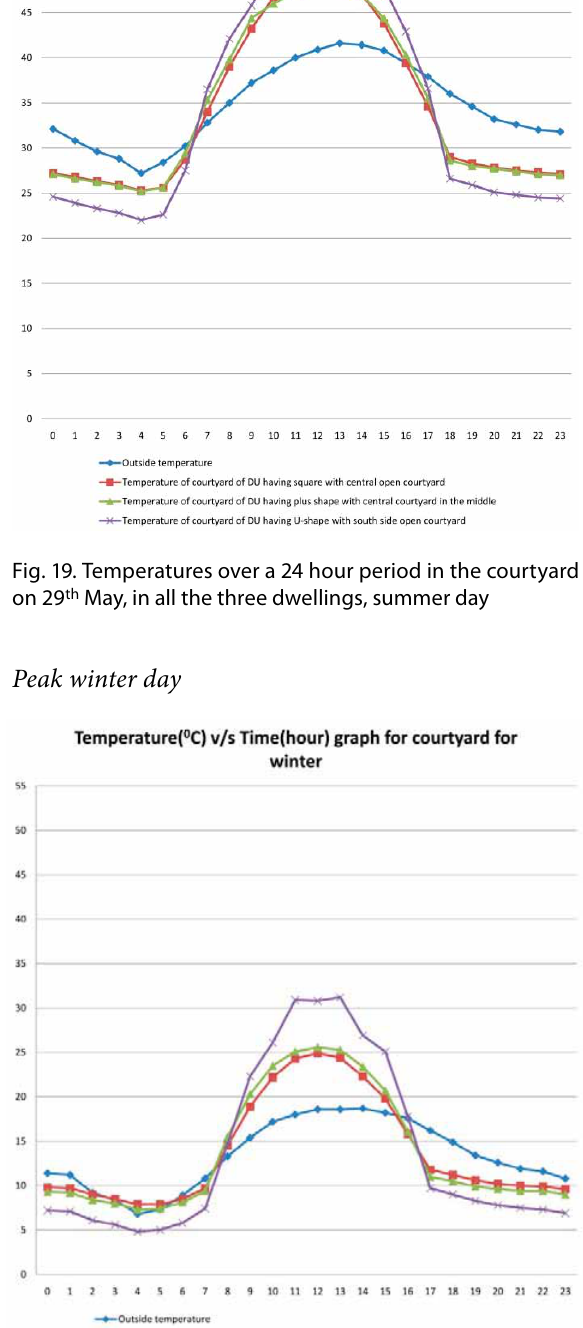
fig. 20. Temperatures over a 24 hour period in the courtyard on 4 th january, in all the three dwellings, peak winter